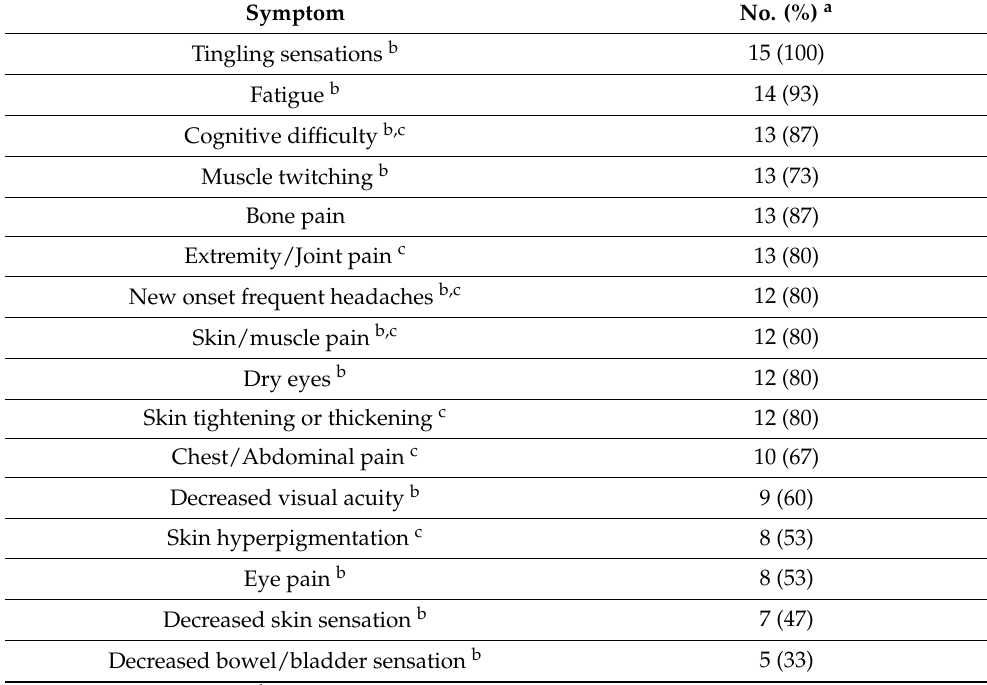
Table 2. Participant symptoms at blood